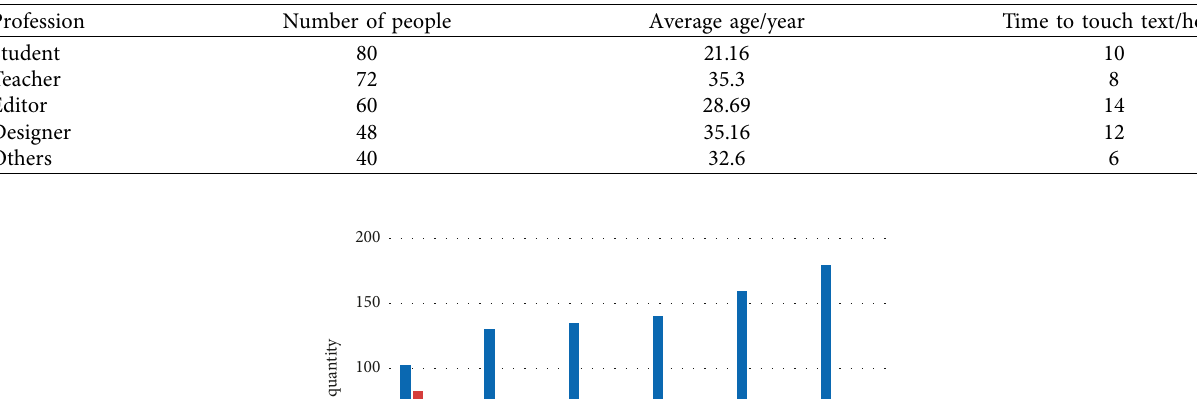
Table 1: Specific information on the study population.